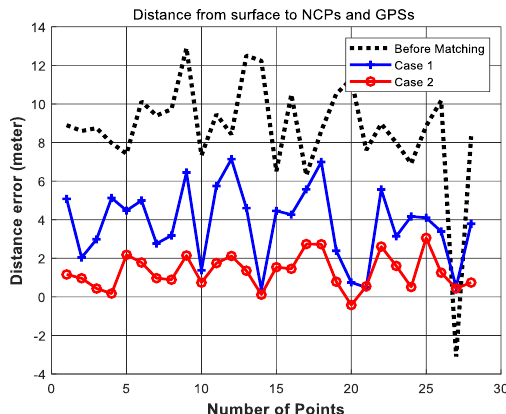
Figure 10. Distance errors from the NCPs and GPS points to surface of DEM before and after matching